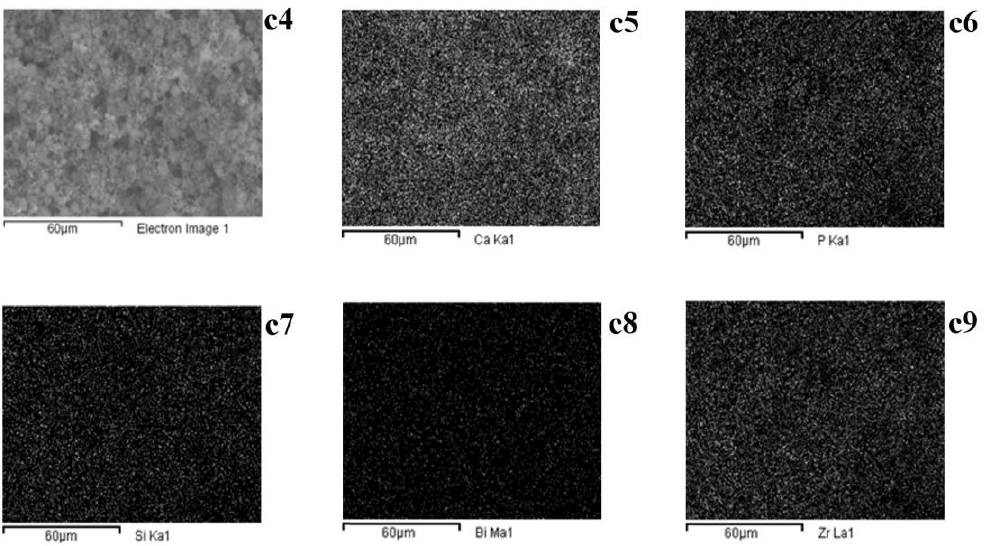
Figure 3. Morphochemical characterization of ProRoot MTA soaked in HBSS. ESEM image of freshly mixed ProRoot MTA ( a1 ) displayed a finely granular surface and EDX analyses (micro-chemical spectrum and semi - quantitative compositional analysis) revealed Ca, Si, Al, and Bi ( a2 , a3 ). After soaking in HBSS ( b1 ), the reflexes of the components Si and Bi decreased in intensity whilst P and C elements increased ( b2 ). After 28 days the surface was coated by irregularly distributed globular CaP precipitates ( c1 ), however, Bi was still detectable ( c2 ). The semi - quantitative compositional analysis showed that the Ca/P atomic ratio decreased with time ( b3 , c3 ). At 28 days, the Ca/P atomic ratio was approximately 1.4 ( c3